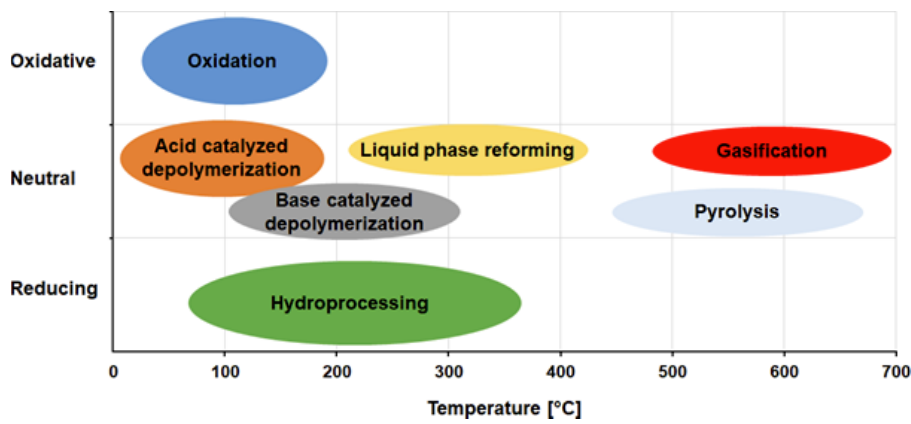
Figure 6. Overview of the chemical and thermal lignin conversion processes (modified from Li et al., 2015).